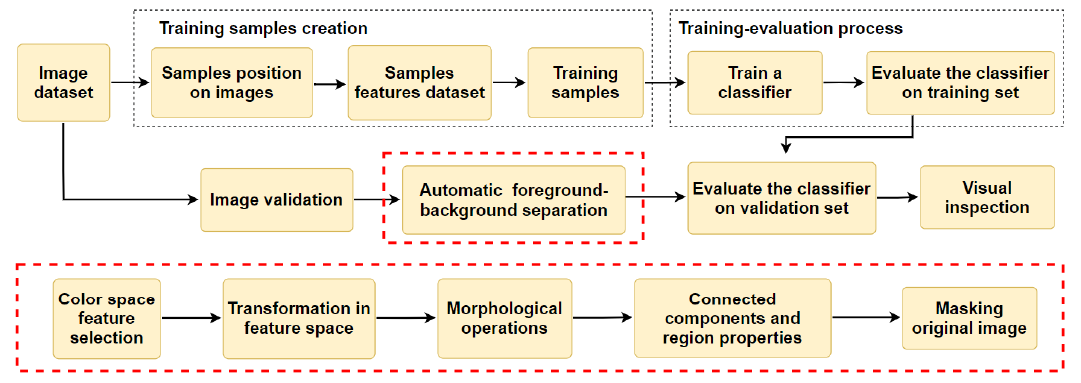
Figure 2. Workflow of the image processing module